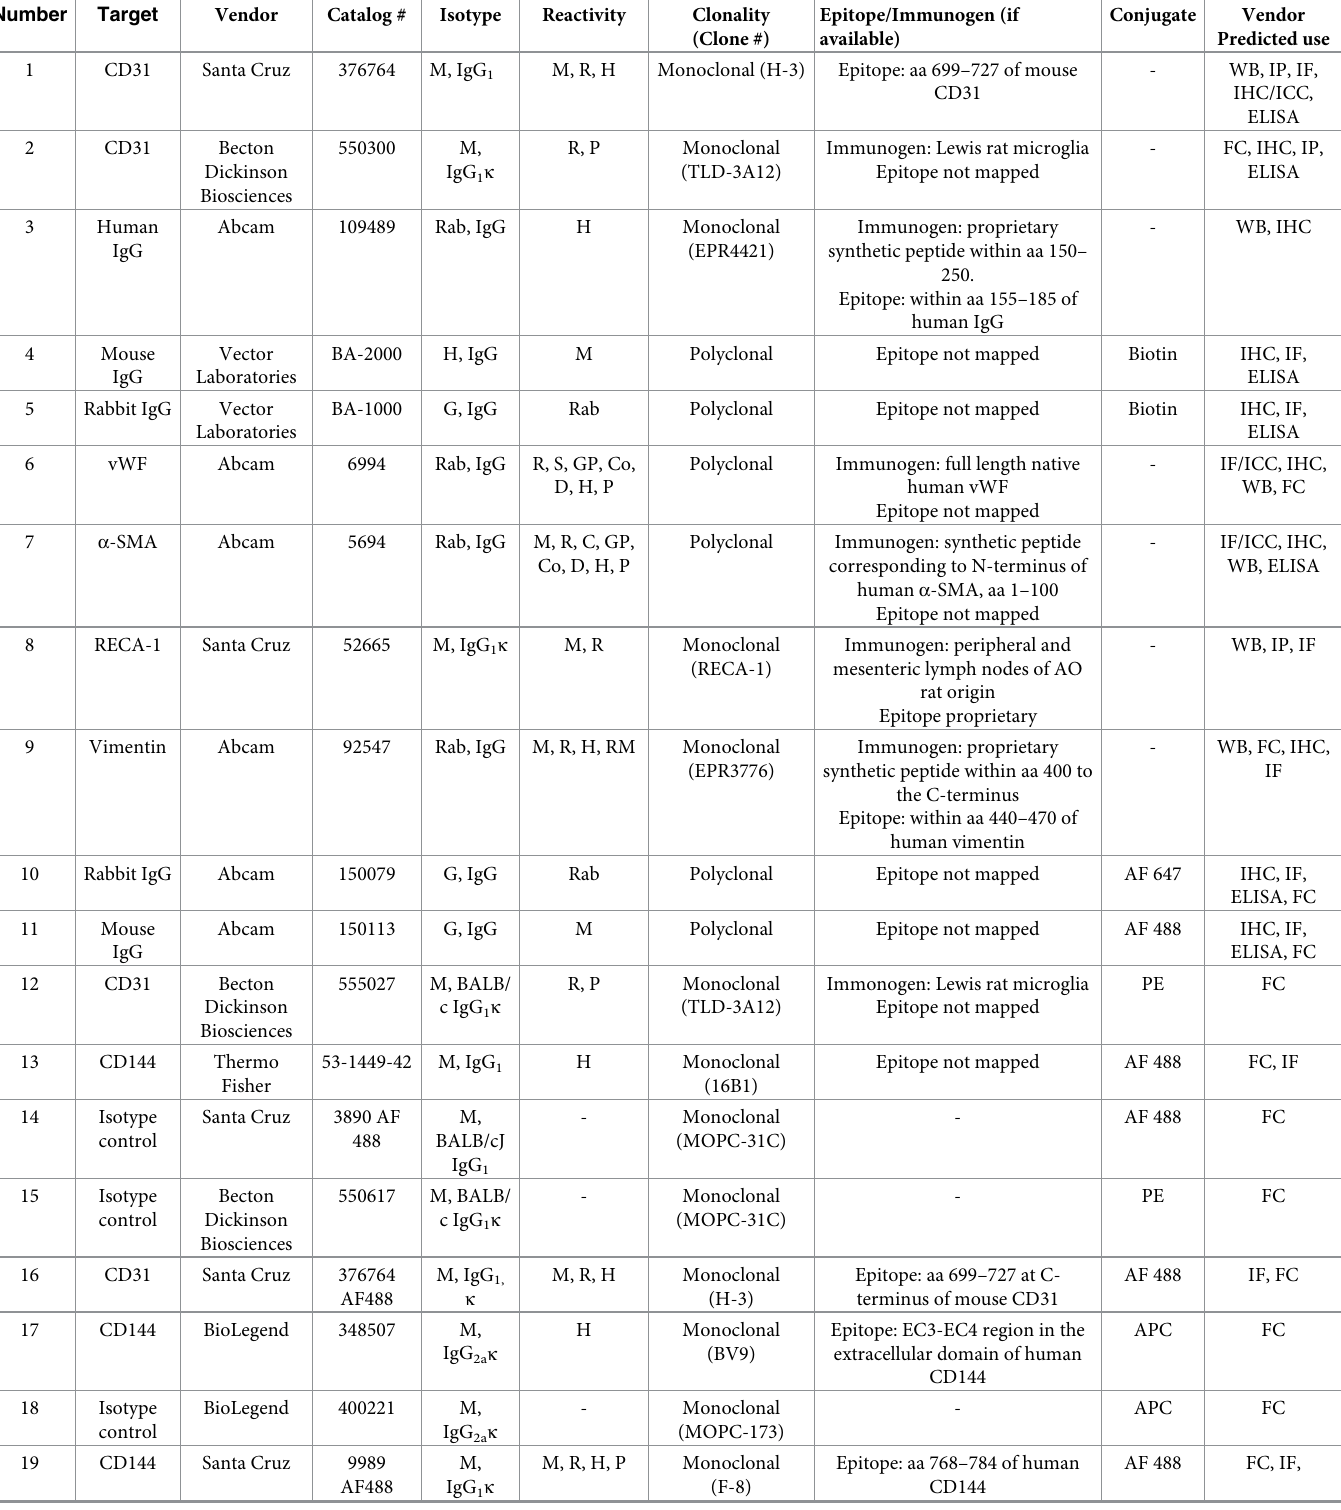
Table 1. Characteristics of antibodies used in